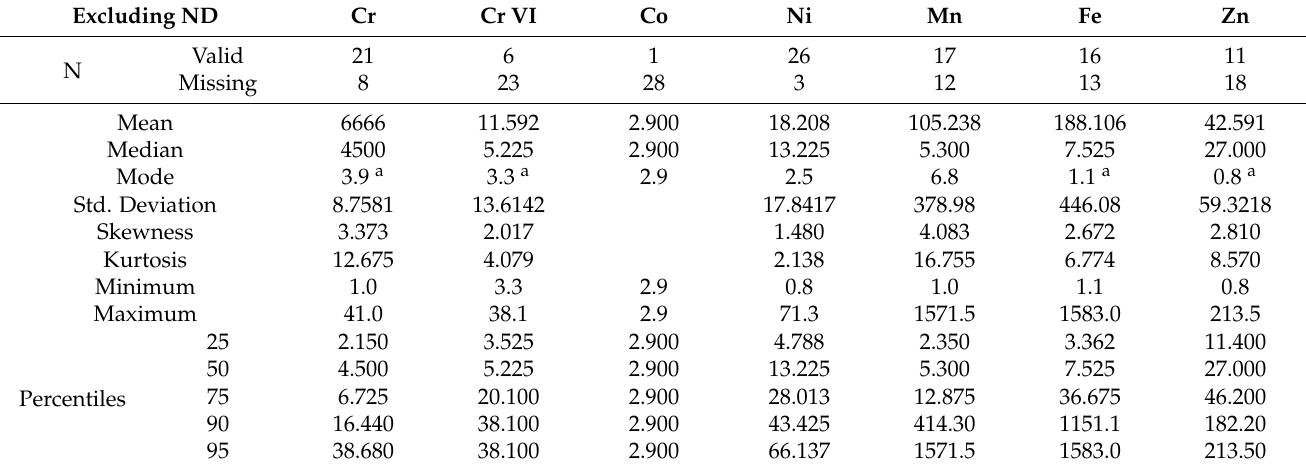
Table 3. Descriptive statistics of the representative PTE values (in µ g/L) for each MS, excluding